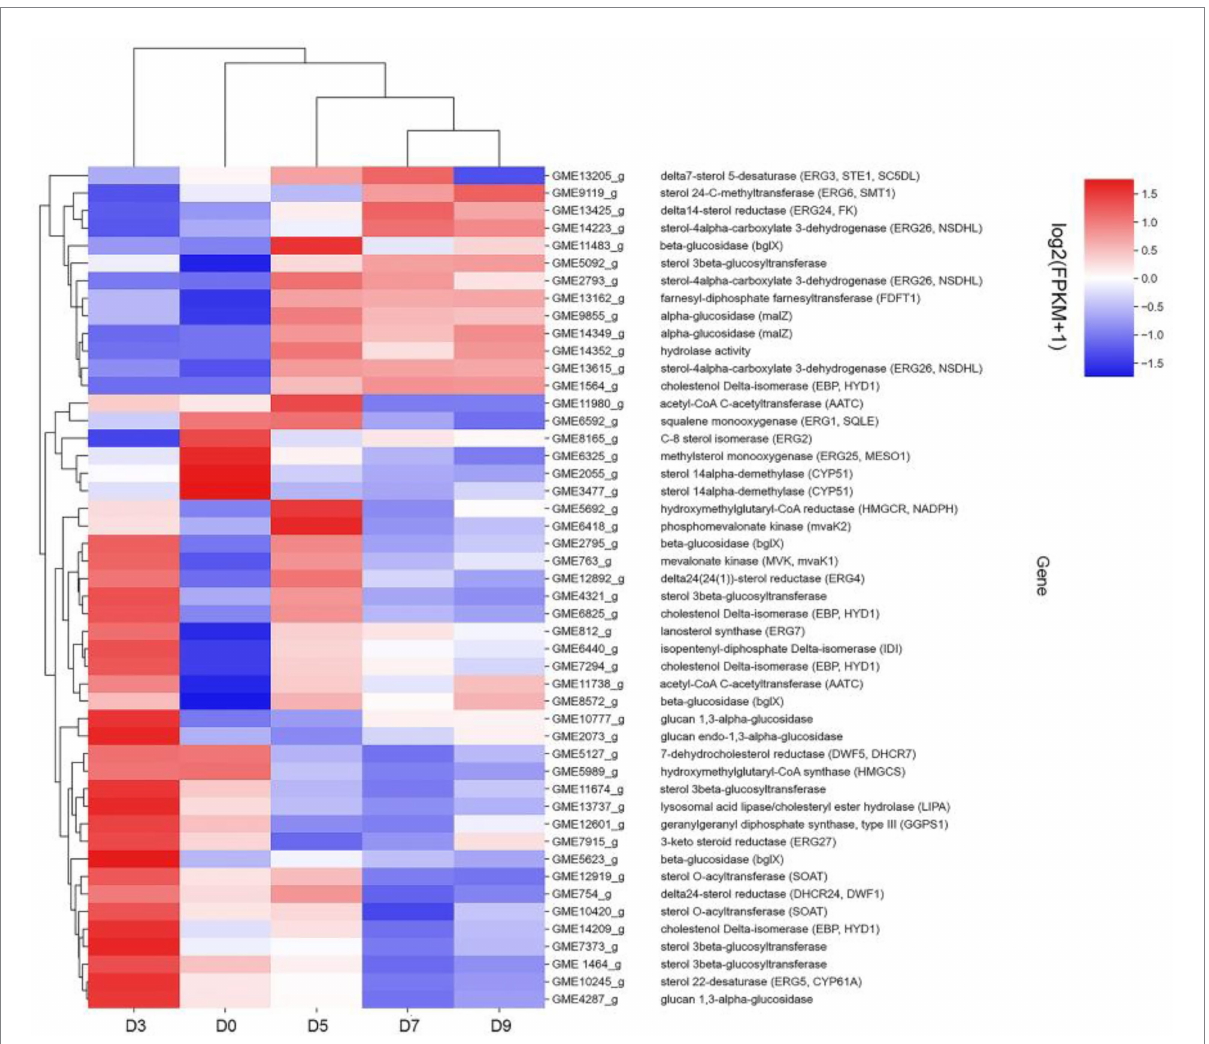
FIGURE 11 DEGs expression heatmap related to the synthesis and transformation of steroidal saponins by strain C39. The color from blue to red indicated log2 (FPKM +1) from low to